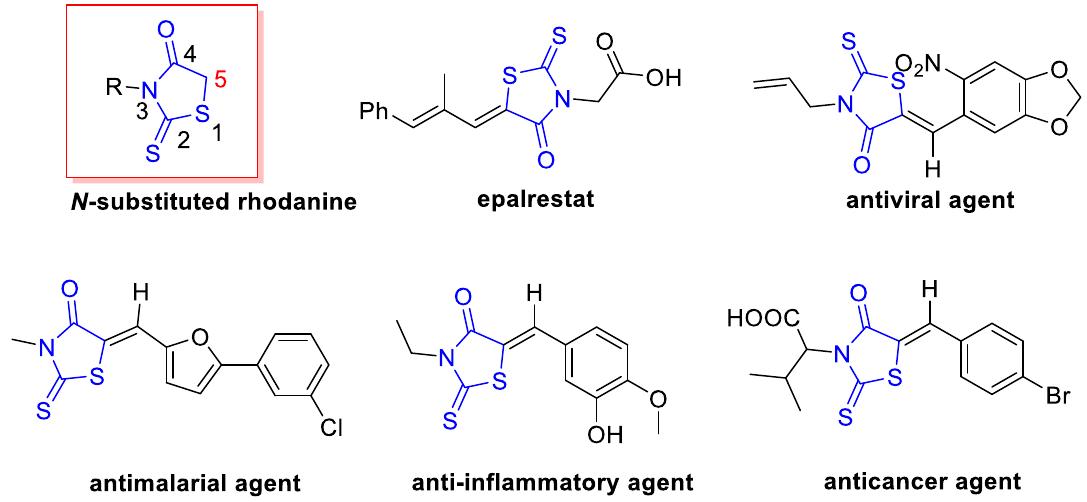
Figure 1. Selected pharmaceuticals and representative compounds bearing N -substituted rhodanines.